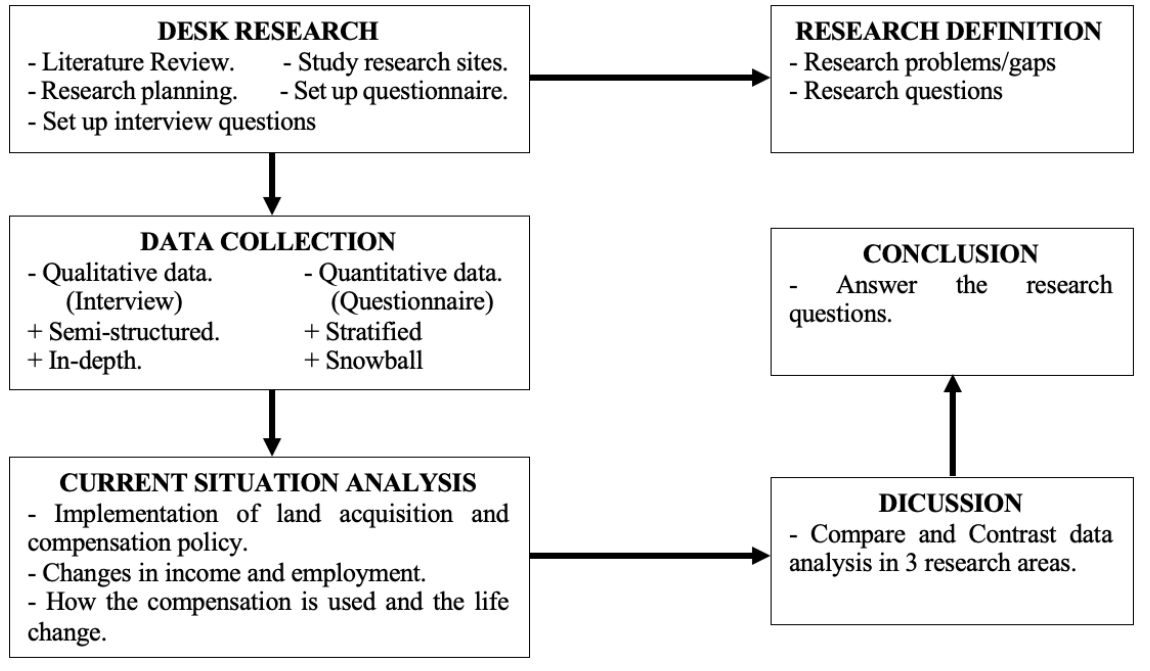
Figure 2. Research design. Table 2. Interview and questionnaire